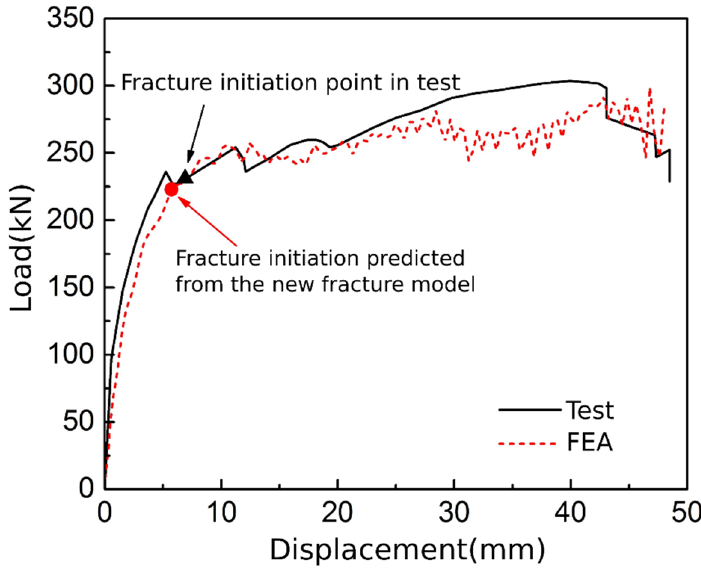
Figure 6. Load–displacement of the RP-1 specimen obtained from the test and finite element analysis.